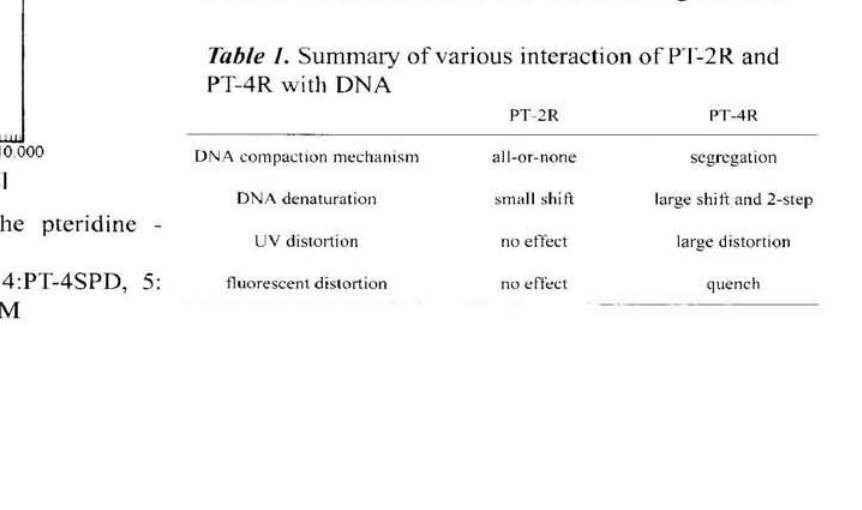
Table l. Summary of various interaction of P r-2R